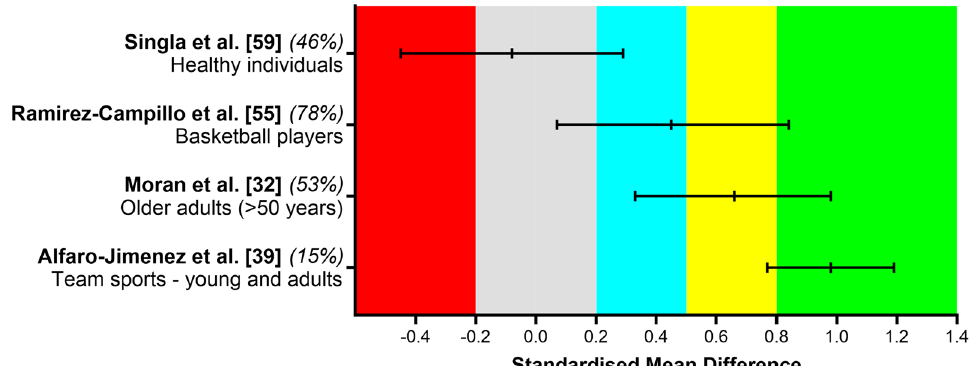
Fig. 5 Summary of standardized mean difference and 95% confidence intervals reported in meta‑analyses comparing the baseline to post‑plyometric training changes on power or explosive muscular strength performance. Author name and year are followed by the quality of the studies score ranked by AMSTAR 2. Positive values represent improved performance effects and negative values detrimental effects. Each colored area represents a different magnitude of effect: gray represents detrimental effects. Alfaro‑Jimenez et al. [38] investigated the effects on explosive strength and the other authors on muscular